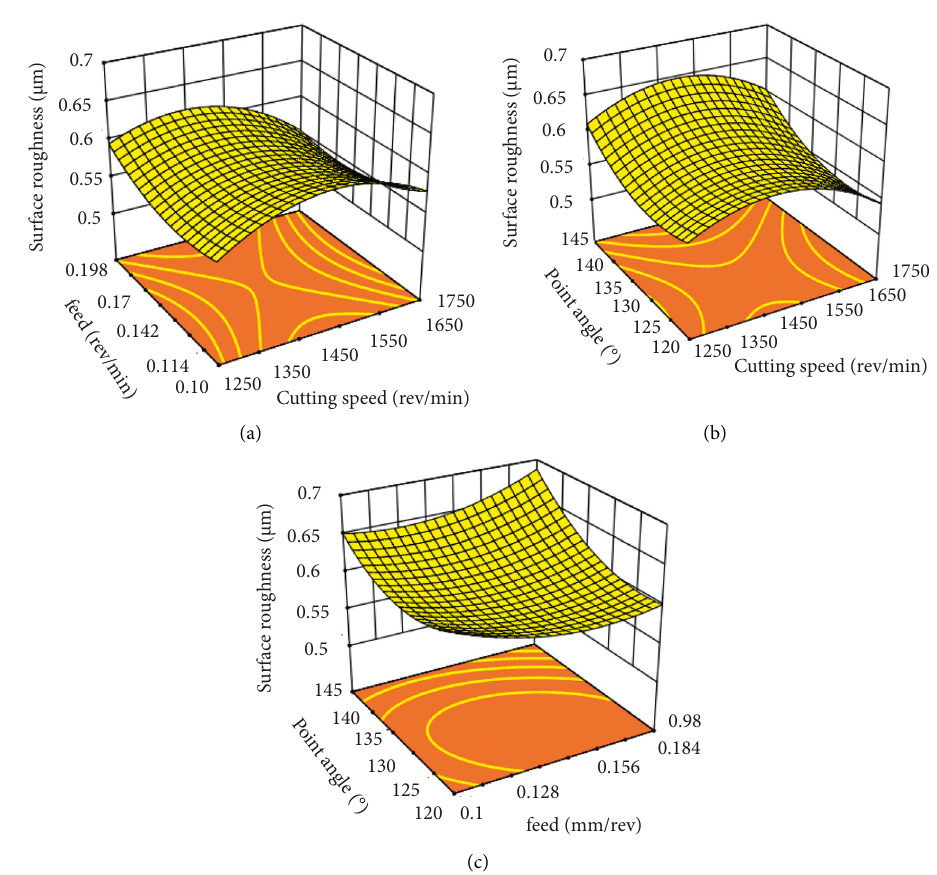
Figure 6: 3D plot for surface roughness: (a) cutting speed vs feed rate, (b) cutting speed vs point angle, and (c) feed rate vs point angle. Table 6: ANOVA for surface roughness. Source